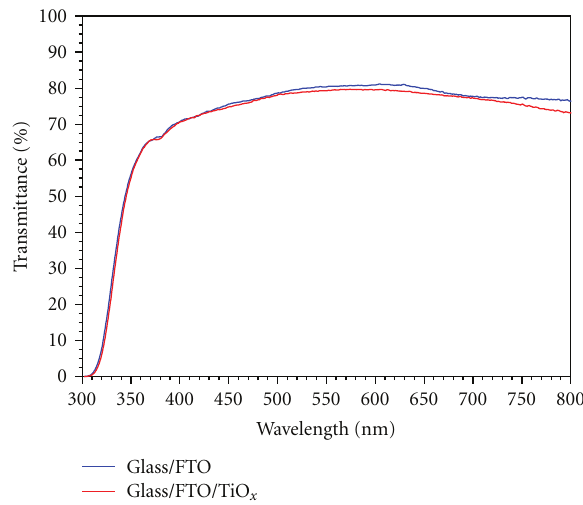
Figure 4: Transmittance of pristine glass/FTO (blue curve) and glass/FTO with the deposited TiO x (red curve).